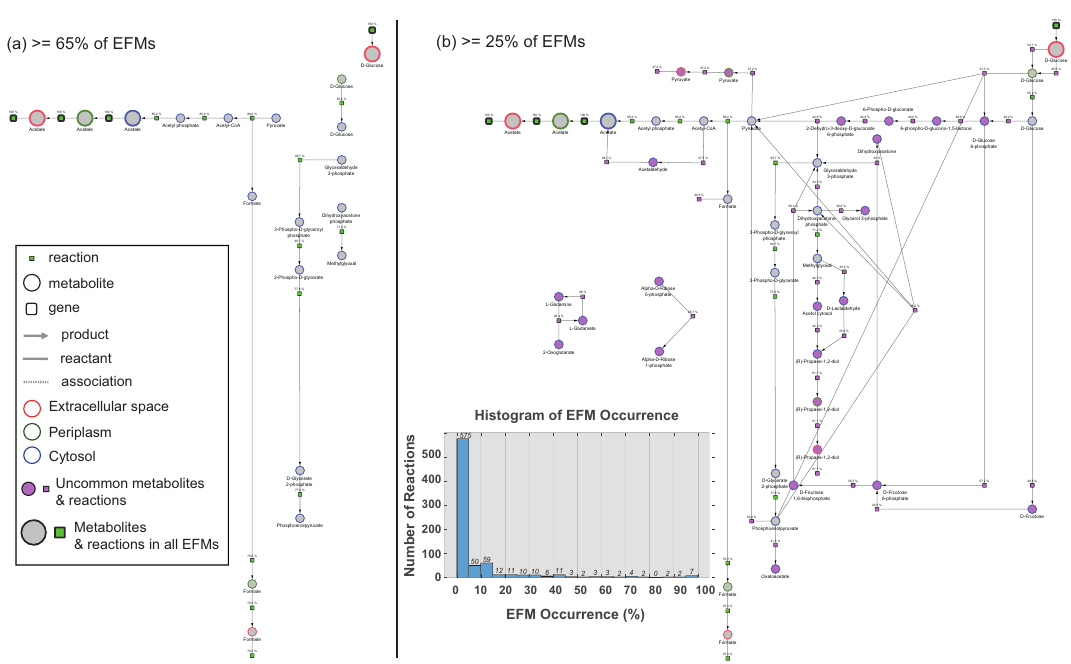
Figure 5. Backbone reactions present in ( a ) greater than 65% and ( b ) greater than 25% of acetate-release EFMs from E. coli . Metabolite node colors indicate the intracellular location, extracellular space (red), cytosol (blue) and periplasm (green). Metabolites and reactions that are different between the two networks are highlighted in pink. Inset shows the distribution of reactions occurring in different proportions of EFMs. The NDEx links http://bit.ly/2SCruPi and http://bit.ly/2Q6ry8i can be used to study the networks